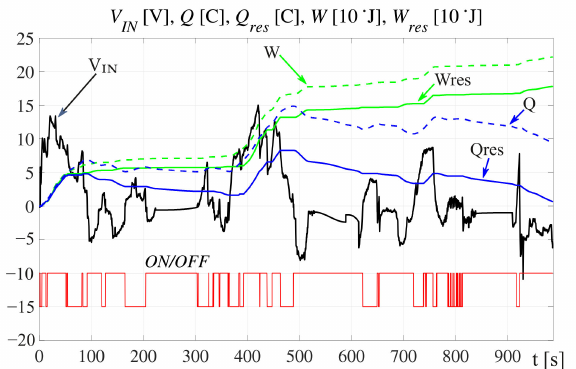
Figure 12. The results of applying EGRA. Input voltage (black), charge balance without any charge balancing algorithm (dashed blue), charge balance with EGRA (blue), energy utilized without any charge balancing algorithm (dashed green), energy utilized with EGRA (green), the ON/OFF signal of the EH device (red).